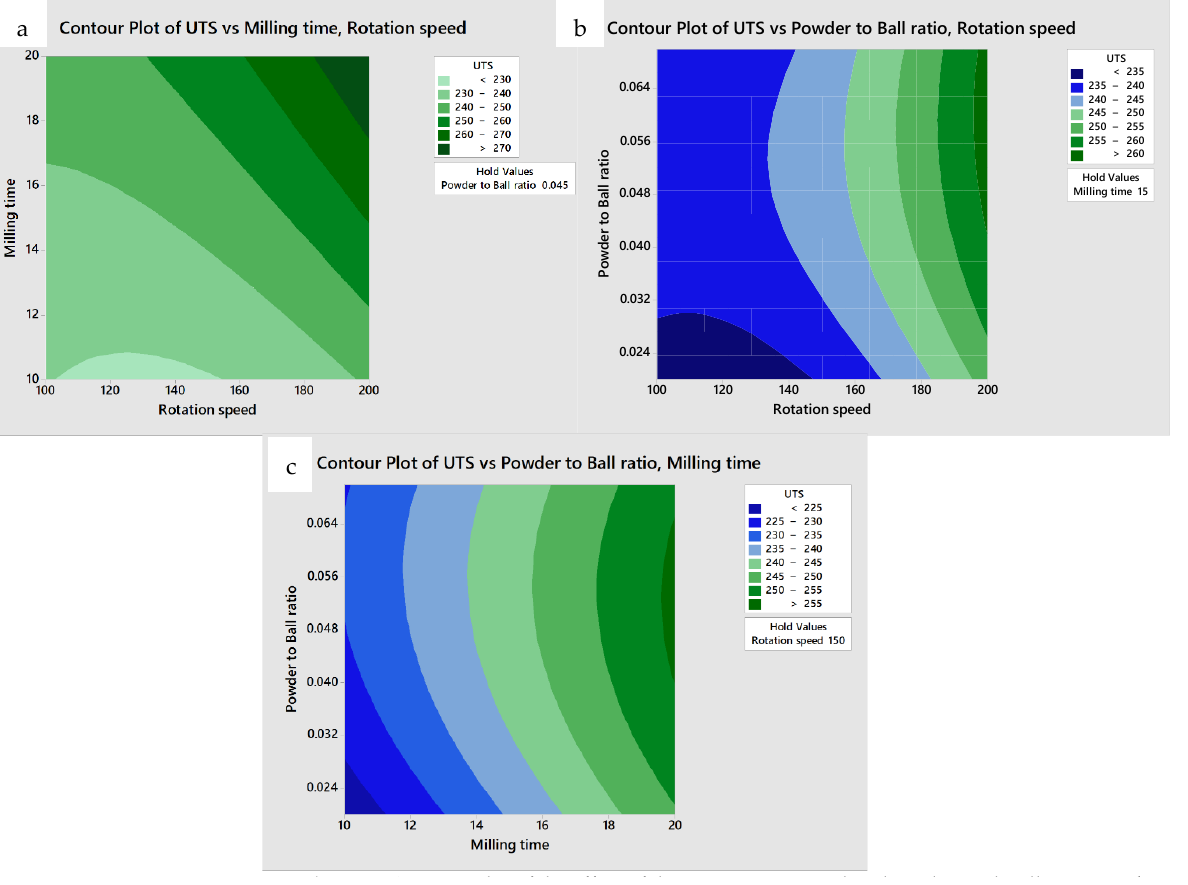
Figure 3. Contour plot of the effect of the ( a ) rotation speed and mechanical milling time, ( b ) rotation speed and powder-to-ball ratio, and( c ) mechanical milling time and powder-to-ball ratio on UTS.